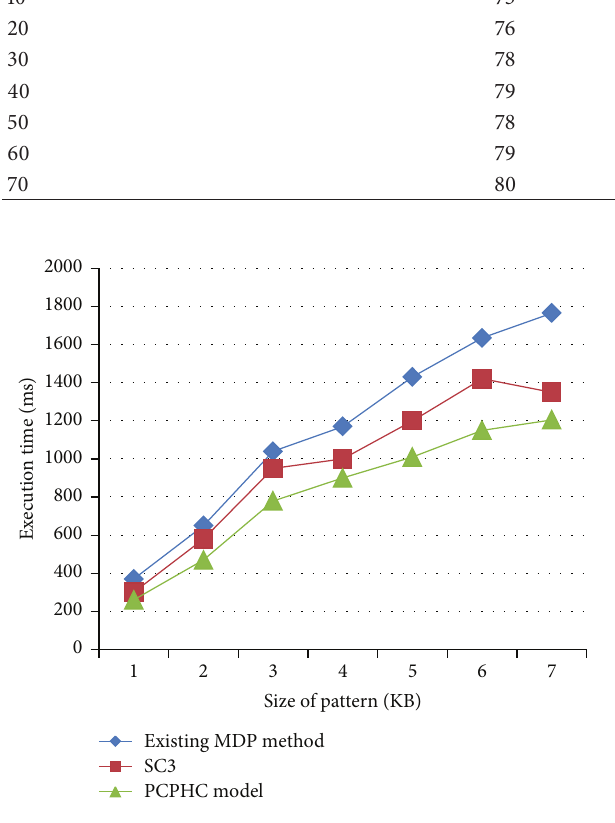
Figure 2: Measure of execution time (using GenBank database).